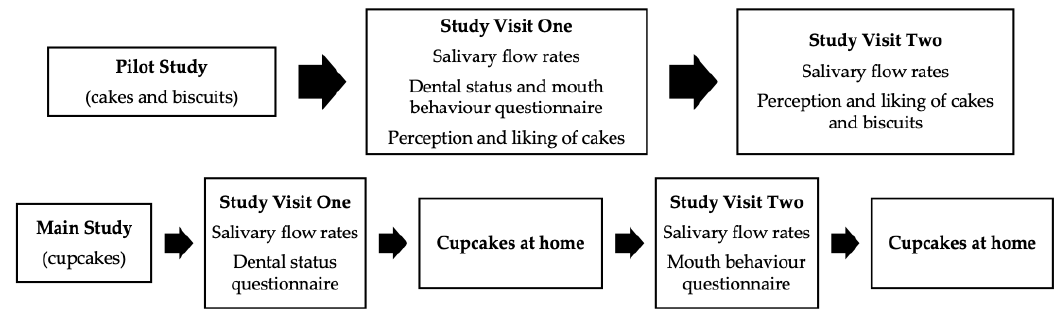
Figure 1. Overview of pilot and main studies.